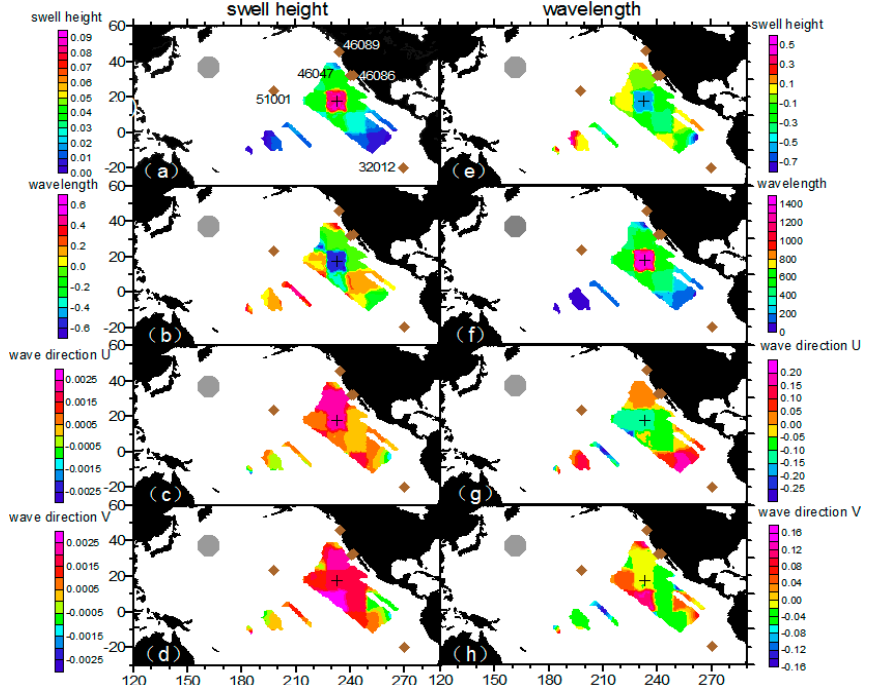
Figure 10. Forecast covariance of sampled state predication of swell height at observation grids and state prediction ( a ) swell height; ( b ) wavelength; ( c , d ) wave direction at an assimilation point (232.83° E 17.64° N) at 21-Jan-2009 09:00:00. Forecast covariance of sampled state predication of wavelength at observation grids and state prediction ( e ) swell height; ( f ) wavelength; ( g , h ) wave direction at an assimilation point (232.83° E 17.64° N) at 21-Jan-2009 09:00:00.